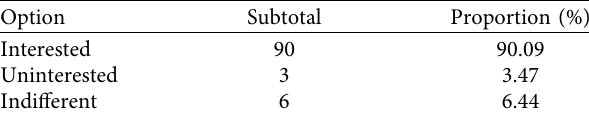
Table 3: Students’ satisfaction with piano quality after